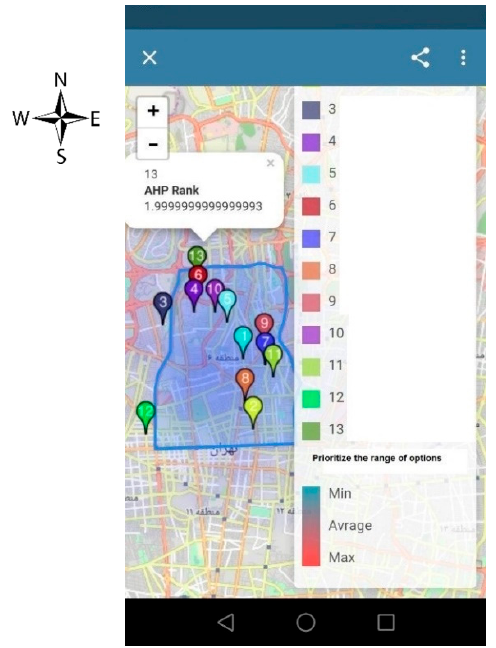
Figure 7. The result of group decision.